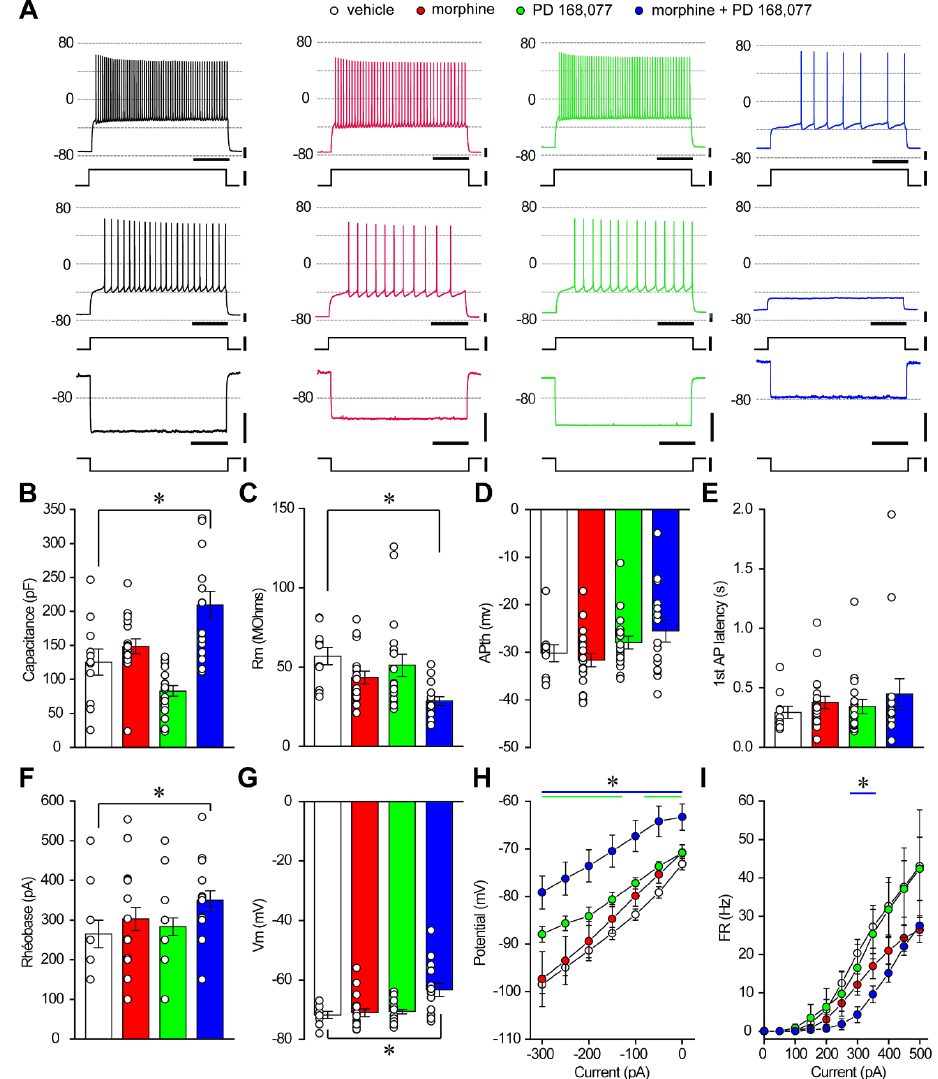
Figure 4. The combined treatment of the D4R agonist PD168,077 with morphine induces changes in passive properties and in excitability of striatal MSNs. ( A ) Representative examples of the voltage responses of identified MSNs of rats treated for 14 days with saline (black), morphine (red; 20 mg/kg/d), PD 168,077 (green; 1 mg/kg/d), and morphine + PD 168,077 (blue, 20 mg/kg/d and 1 mg/kg/d) to two second-long current injection of +300, +200, and −200 pA (top to bottom), respectively. All traces were obtained from neurons that were recorded using a pipette solution complemented with biocytin, and included in the post-recording morphological analysis. ( B – G ) Population graphs depicting significant differences in membrane capacitance ( B ), membrane resistance (RM, C), action potential threshold (APth, D), first action potential latency ( E ), rheobase ( F ), and membrane potential (Vm, G) only in the morphine+PD168,077 group. ( H ) Graph showing voltage deflections in response to injection of negative currents (−50 pA steps) in the four experimental groups. ( I ) Graph showing driven activity in response to injection of positive currents (+50 pA steps) in the four experimental groups. Note that current injection evokes significantly milder responses in the morphine + PD showed group. The data only include values obtained from the neurons that were reconstructed and thus included in the post-recording morphological analysis. In B – G , data were compared using Kruskal-Wallis test followed by a Dunn’s post hoc test. In H , I , data were compared using mixed model ANOVA followed by Dunnet’s post hoc test * p <